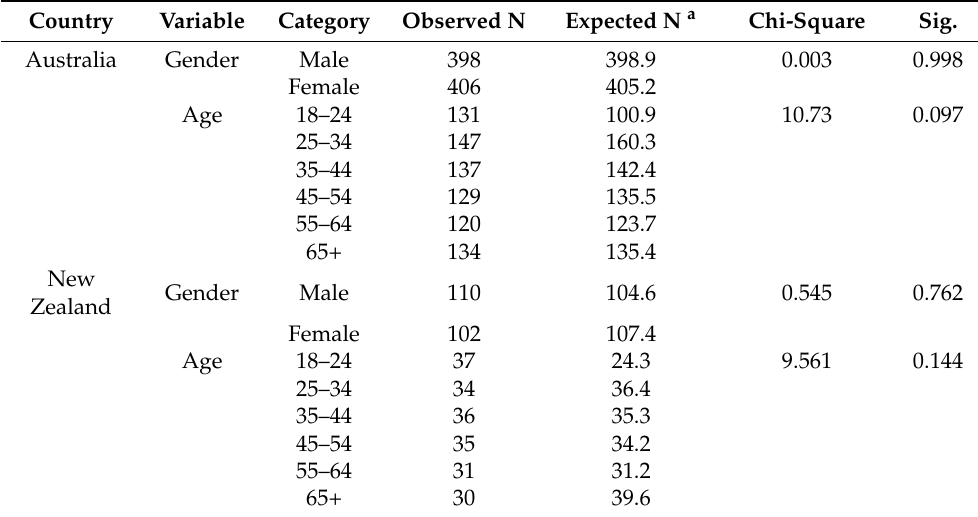
Table A2. Chi-square difference tests for age and gender